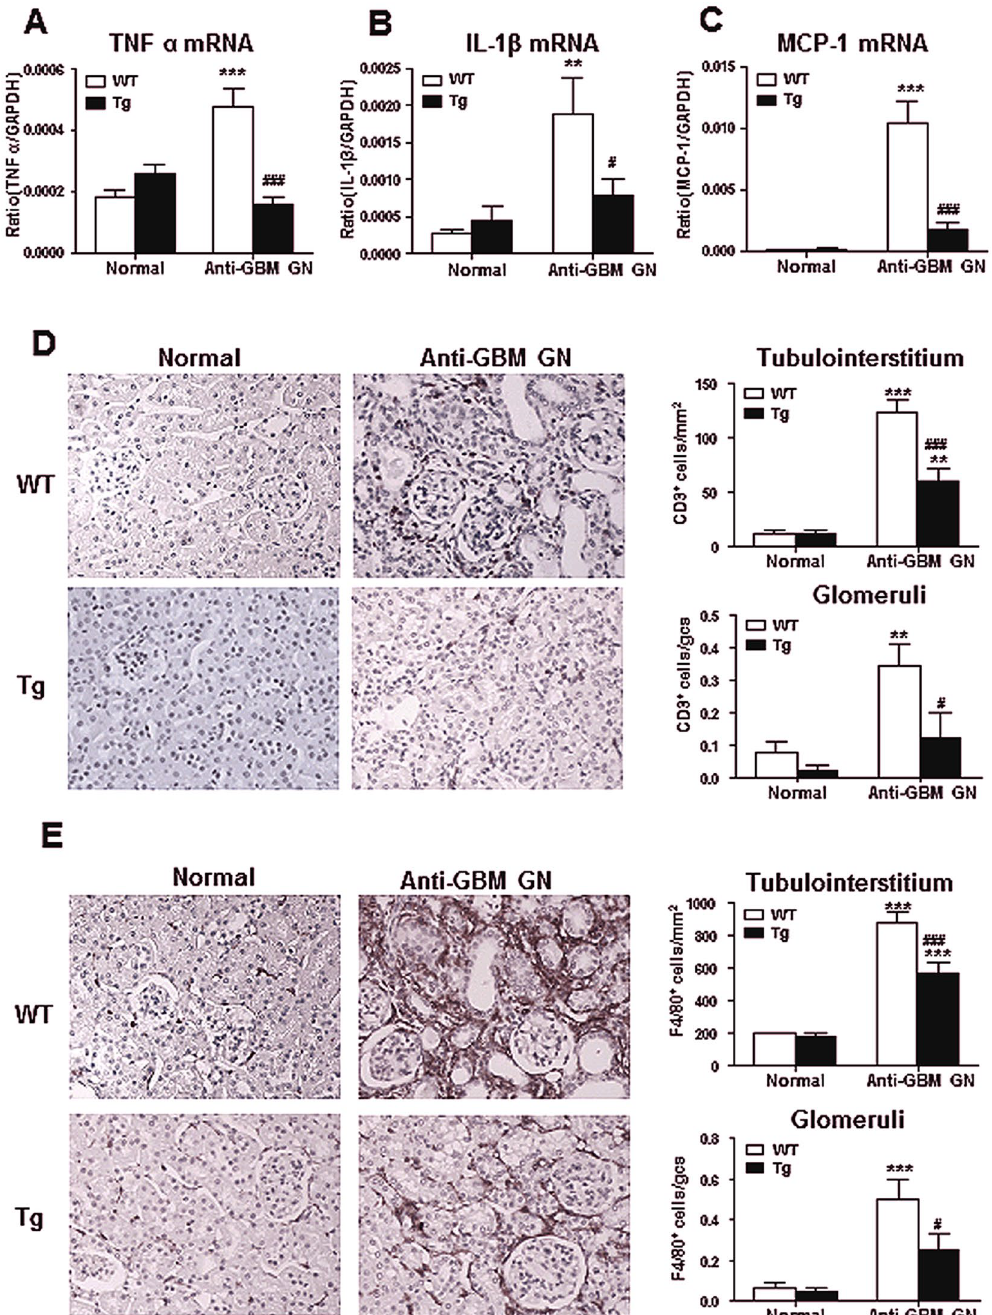
Figure 2. Foxp3 inhibits up-regulation of inflammatory cytokines and cell-mediated kidney injury in anti- GBM GN. Results of Real time PCR show renal inflammatory cytokines (( A ) TNF- α and ( B) , IL-1 β ) and chemokine (( C ), MCP-1) mRNA expression in normal and anti-GBM GN (day 14) in both WT and Tg mice. ( D ) Immunohistochemistry shows that macrophage (stained for F4/80 + ) infiltration within the kidney with anti-GBM crescentic GN on Day 14 after disease induction is markedly inhibited in Foxp3 Tg mice. ( E ) Immunohistochemistry shows that CD3 + T cell (stained with anti-CD3 antibody) infiltration within the kidney with anti-GBM crescentic GN on day 14 is notably inhibited in Foxp3 Tg mice. Each bar represents mean ± SEM. ** p < 0.01 and *** p < 0.001 compared with normal mice; # p < 0.05 and ### p < 0.001 compared with the WT mice. n = 6–8 mice per group. Original magnification 200X ( D , E